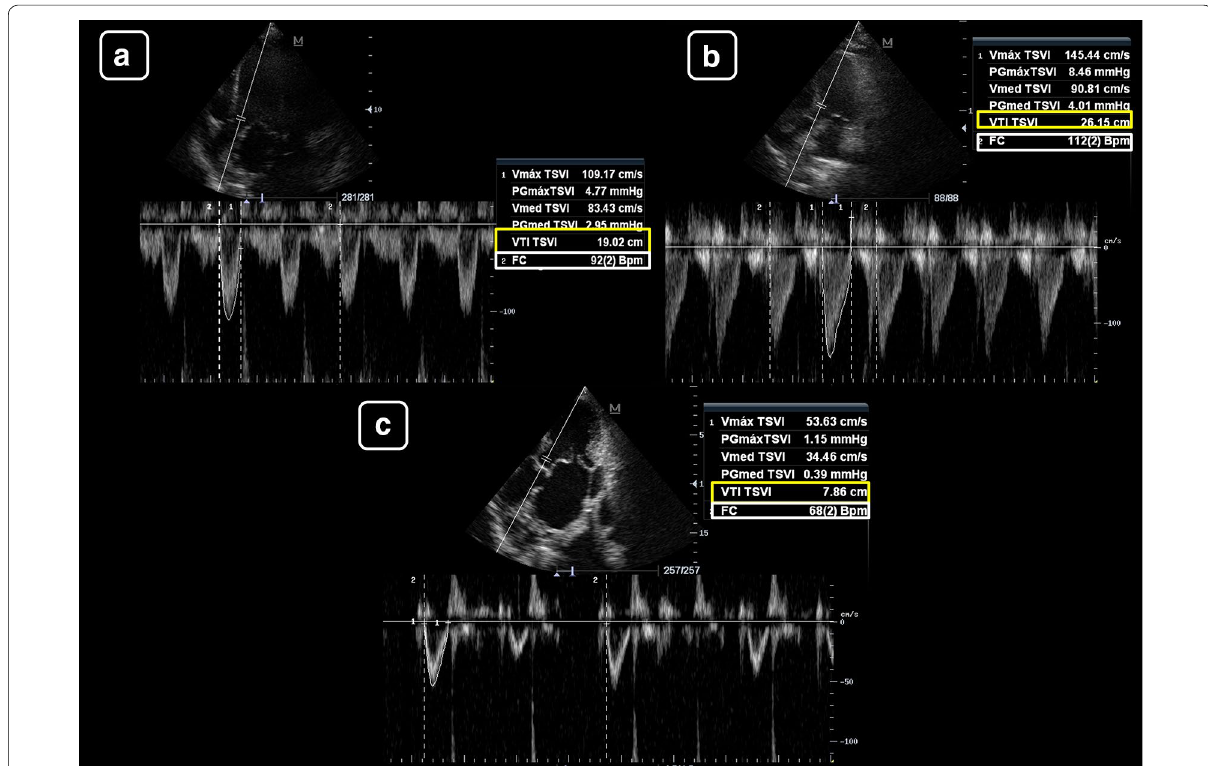
Fig. 6 Absolute values of the left ventricular tract velocity–time integral (LVOT VTI, yellow boxes) and minute distance (LVOT boxes)) for estimating the stroke volume (SV) and cardiac output (CO), respectively. a LVOT VTI of 19 cm and HR of 93 beats/min, indicating a normal SV and CO (the minute distance is 1748 cm/min). b LVOT VTI of 26 cm and HR of 113 beats/min, indicating a high SV and CO (the minute distance is 2912 cm/min). c LVOT VTI of 8 cm and HR of 68 beats/min, indicating a low SV and CO (the minute distance is 544